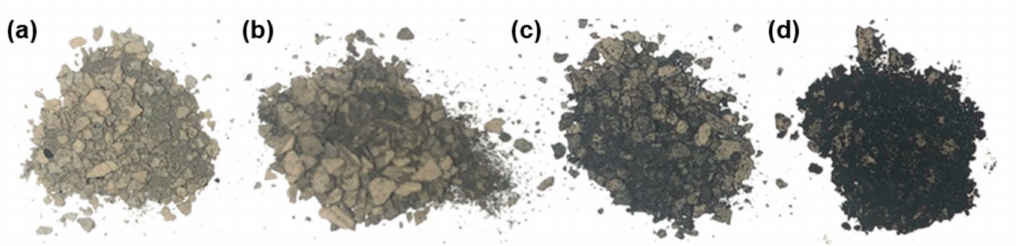
Figure 7. Various PrintexU–cordierite mixtures with a volume fraction ν soot of PrintexU of: ( a ) 0.5%, ( b ) 1.5%, ( c ) 5.0%, ( d )